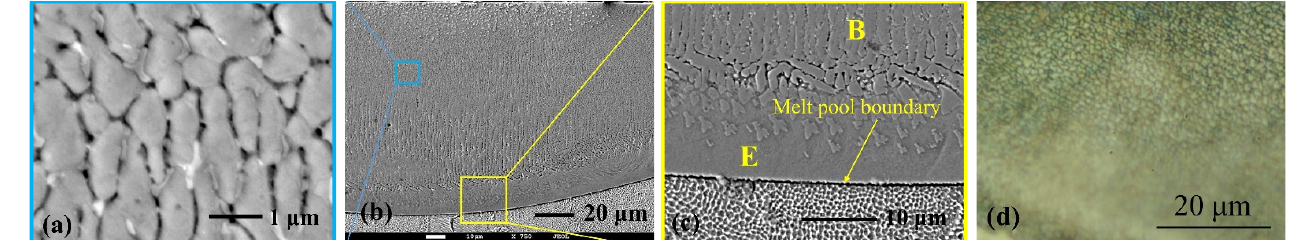
Figure 11. Hypereutectic microstructure of layer laser-boronized at 1500 mm/min laser operating speed: ( a ) structure of ultra-fine dendritic borides and residues of eutectic between them; ( b ) general view of the melt pool—mainly dendritic microstructure with dendrite direction variation in various melt pool areas; ( c ) layer of planar solidification near melt pool boundary with boride dendrites in transvers direction; ( d ) optical micrograph of microstructure after coloring etching; E—eutectic; B—borides.